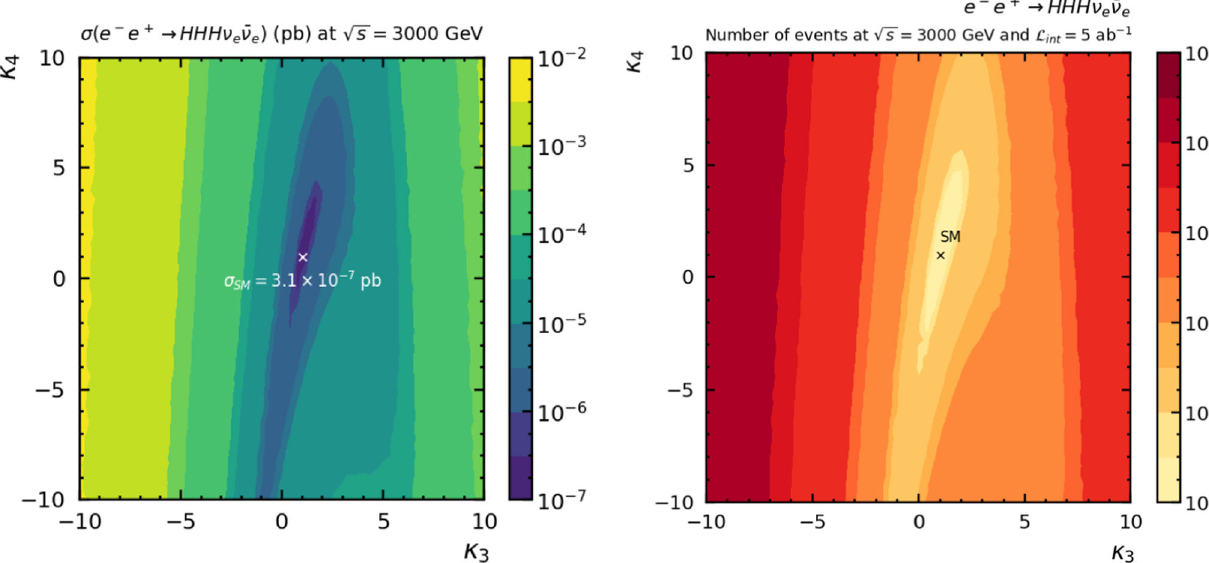
Fig. 26 Total cross section of e + e − → H H H ν e ¯ ν e as a function of κ 4 (with κ 3 fixed to 1) for different values of the CM energy the right shows a zoom around the dip region